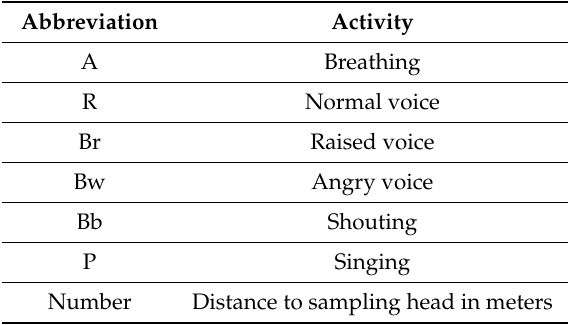
Figure 2. Distribution of aerosols and CO 2 over time. Table 2. Explanation of the letters in Figure